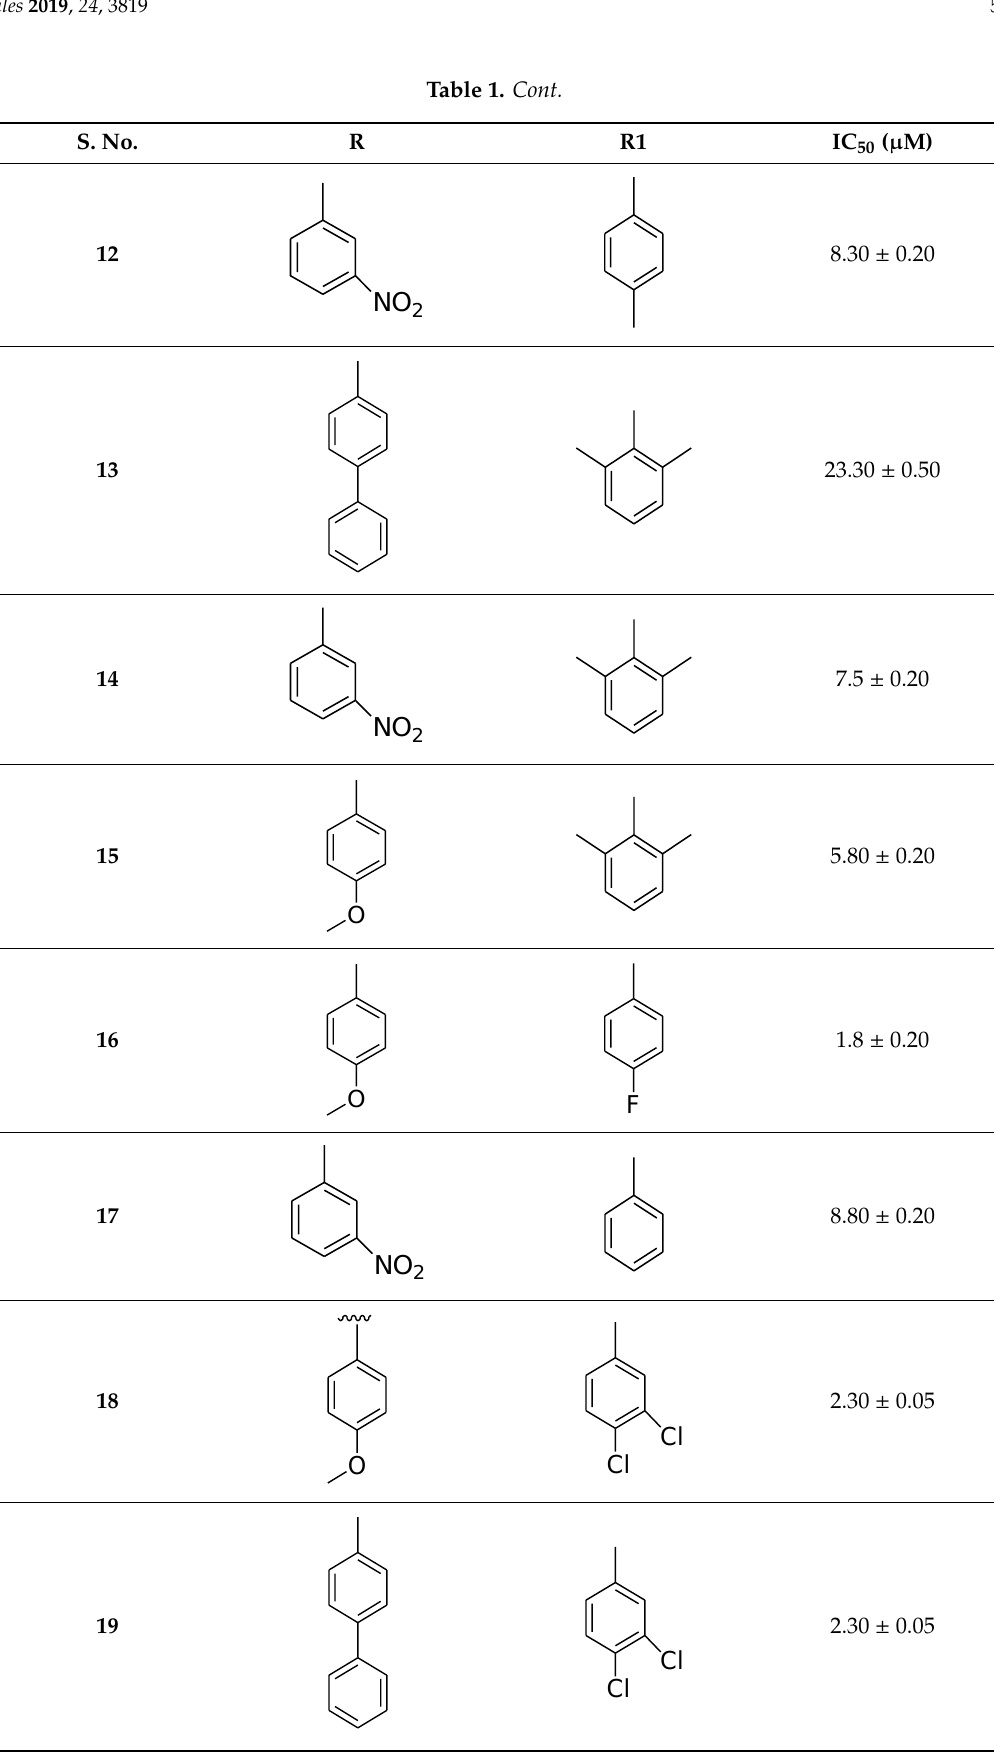
Scheme 2. Synthesis of thiosemicarbazide derivatives. Table 1. Cont.